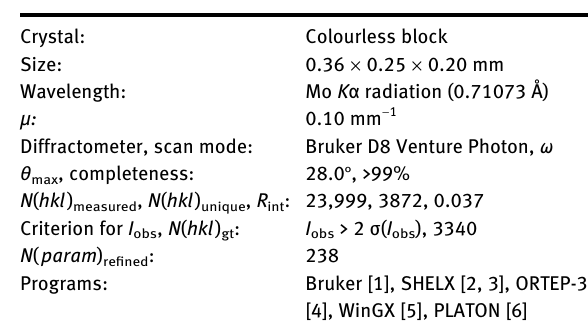
Table  : Data collection and